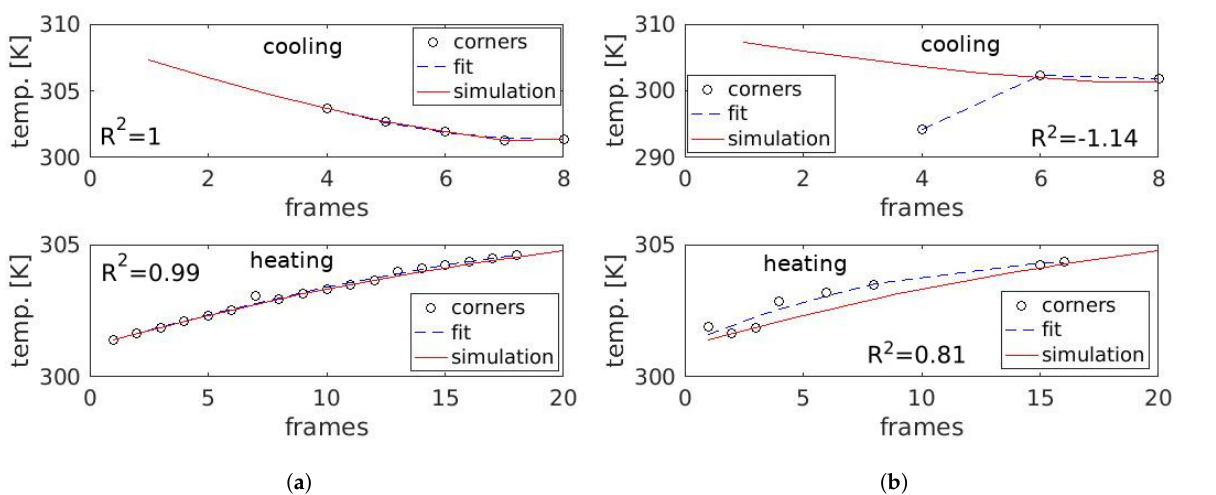
Figure 11. Fitting examples of cooling ( top graph ) and heating ( bottom graph ) for four different traces: ( a ) with high value of R 2 for both processes: 1 and 0.99, respectively, ( b ) with negative value for cooling ( R 2 = − 1.14) and positive for heating ( R 2 = 0.81).